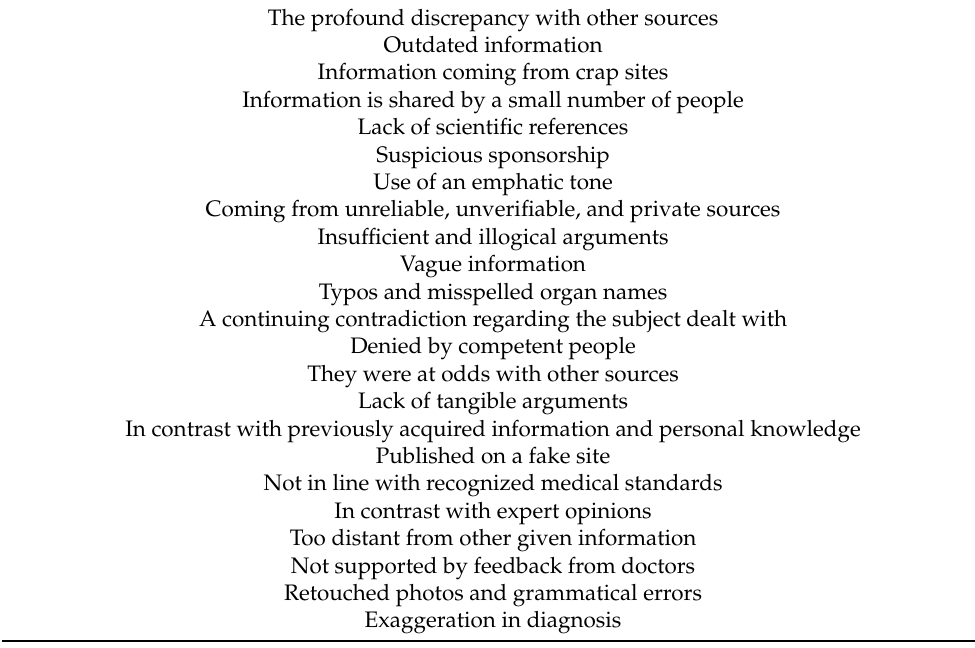
Table 10. Criteria suggested by respondents to determine if the information is false.